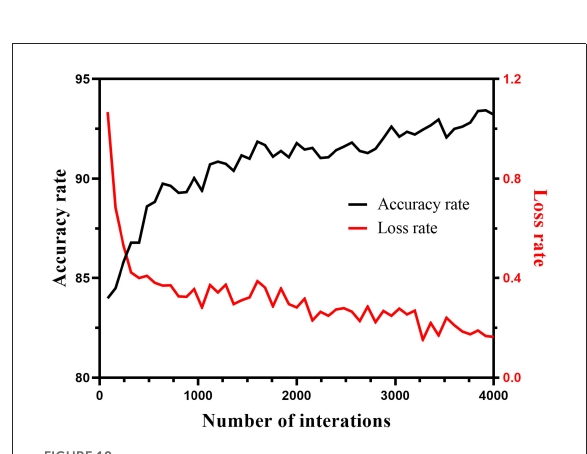
FIGURE10 Variation trend of loss rate and accuracy rate in the training process of F-RNet model.